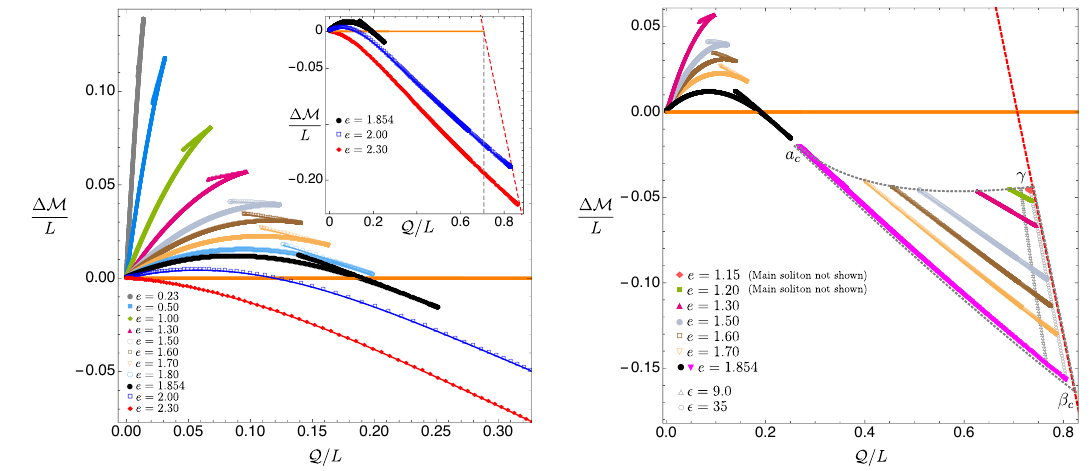
Figure 2 . Quasilocal phase diagram for solitons with different scalar condensate electric charges. The quantity ∆ M is the mass difference between the soliton and an extremal RN BH that has the same charge Q /L . Hence the orange line at ∆ M = 0 describes the extremal RN solution. The dashed vertical line in the inset plot describes the line Q = 2 − 1 / 2 which is the maximum local charge that an extremal RN BH can have whilst fitting inside a box with radius R = 1 . The red dashed line represents the maximal quasilocal charge of solutions that can fit inside the box. Left panel: here we give several examples of the main soliton family only. Notice the change in appearance of the curves as we increase the scalar field charge above e c ’ 1 . 8545 (see also inset plot). Right panel: here we concentrate our attention only in cases with e γ < e < e c but, this time, we present both the main and secondary solitons. The secondary solitons only exist in the region bounded by the auxiliary grey dashed closed curve a c β c γ . The secondary soliton curve with e just above e γ is close to point γ , while the soliton with e = 1 . 854 , just below e c , is the magenta curve (very close to a c β c ). Note that the gap in Q /L between the main soliton and the secondary one starts very large at e = e γ but then decreases and goes to zero precisely at e = e c . We also present two secondary soliton curves with constant scalar field condensate, (cid:15) = 9 and (cid:15) = 35 , to illustrate how we can march in e to obtain different solutions and further conclude that secondary solitons are bounded by the auxiliary lines a c γ and a c β c